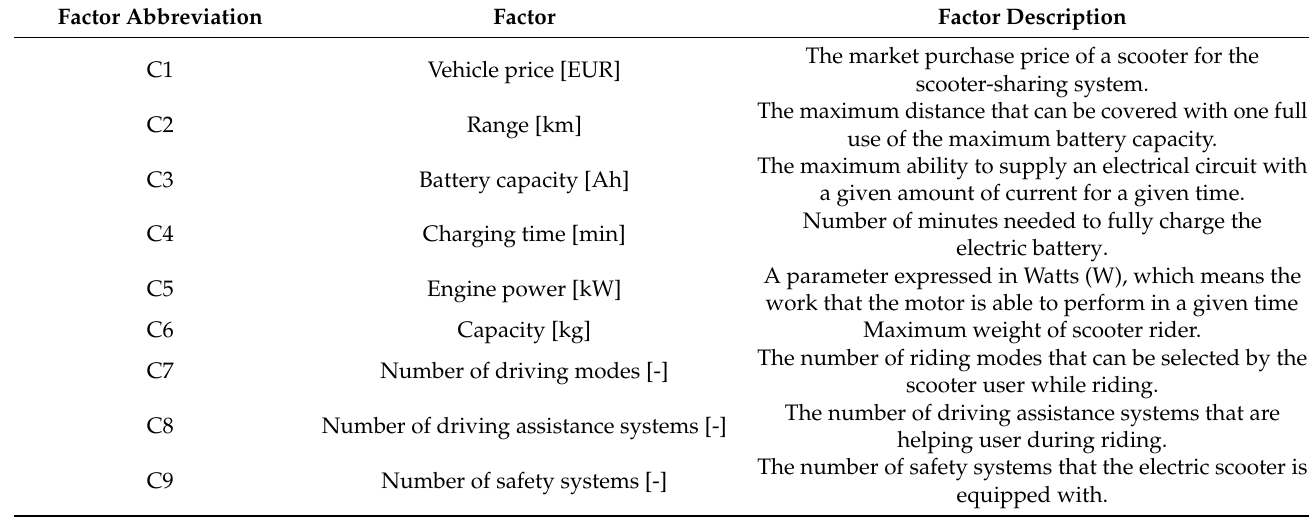
Table 1. Criteria for selecting an electric scooter in shared mobility systems.